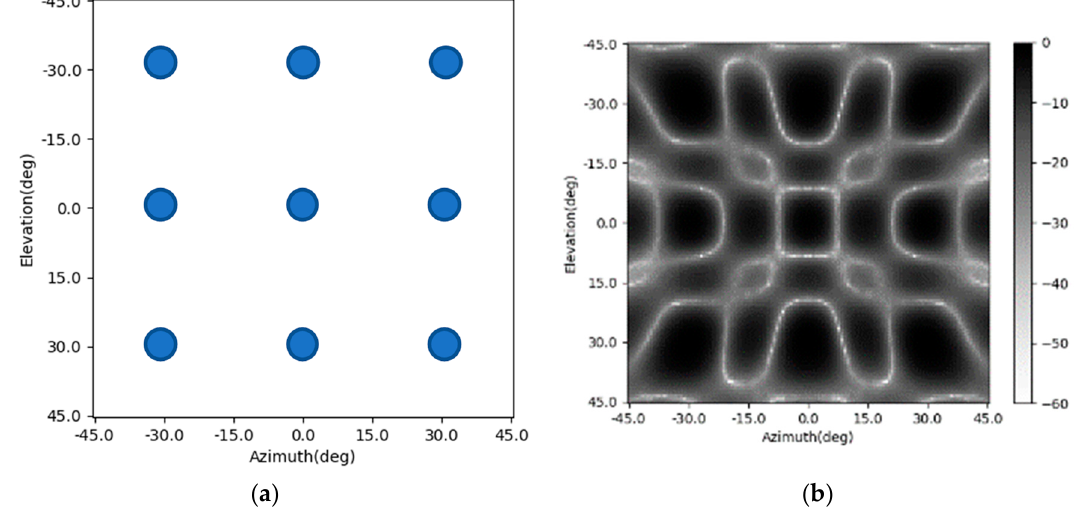
Figure 1. Imaging scene and imaging results; ( a ) imaging scene; ( b ) original radar image.